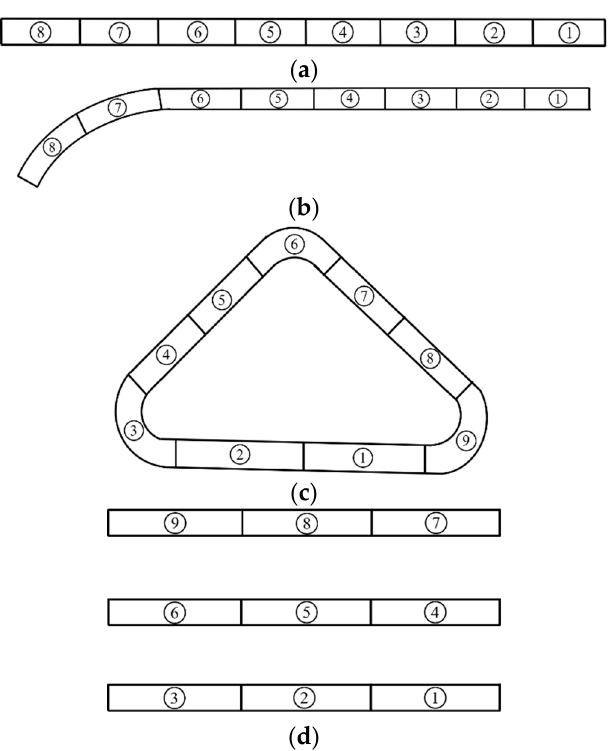
Figure 6. Coding of welding seams for four welded structures: ( a ) welded structure 1; ( b ) welded structure 2; ( c ) welded structure 3; ( d ) welded structure 4.